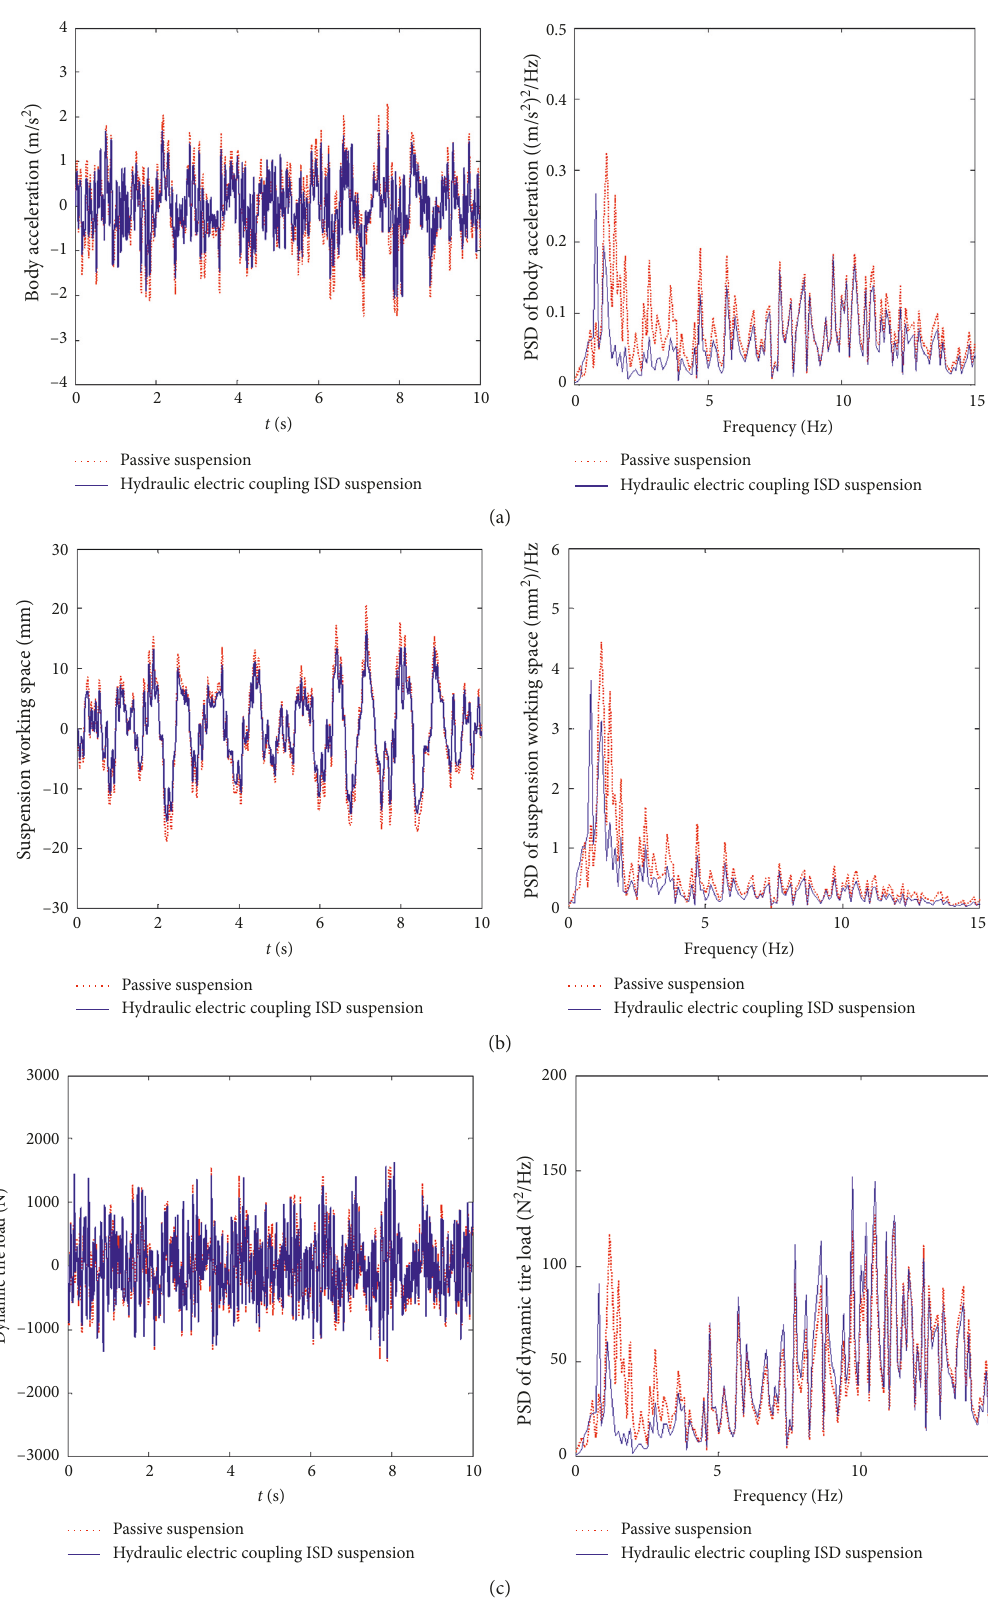
Figure 10: Suspension performance comparison. (a) Body acceleration. (b) Suspension working space. (c) Dynamic tire